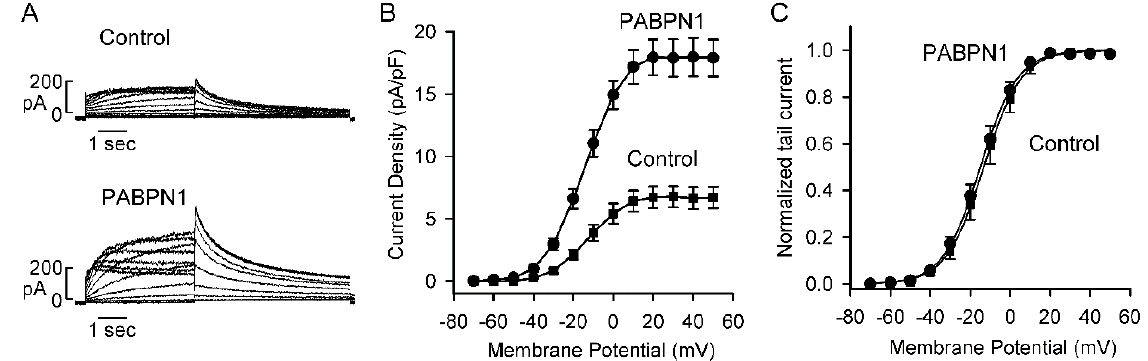
Figure 6. Effect of PABPN1 on Kv11.1 channel current. ( A ) Representative currents recorded from Flp-In HEK293 cells stably expressing the short KCNH2 gene following transfection with GFP vector (Control) or PABPN1+GFP. ( B ) I-V plot of tail current density measured at − 50 mV following test voltages from − 70 to +50 mV for vector-transfected control (squares, n = 10) or PABPN1 (circles, n = 7, error bars, mean ± S.E.). ( C ) Activation curves measured with normalized tail currents and fitted to a Boltzmann equation for vector-transfected control (squares, n = 10) and PABPN1 (circles, n = 7, error bars, mean ±